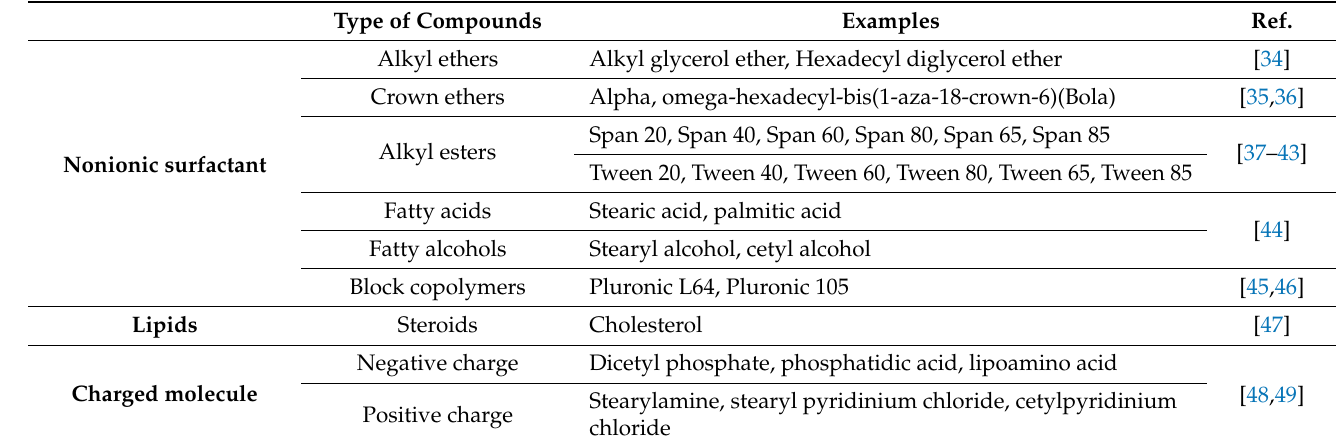
Table 2. Compounds used to obtain